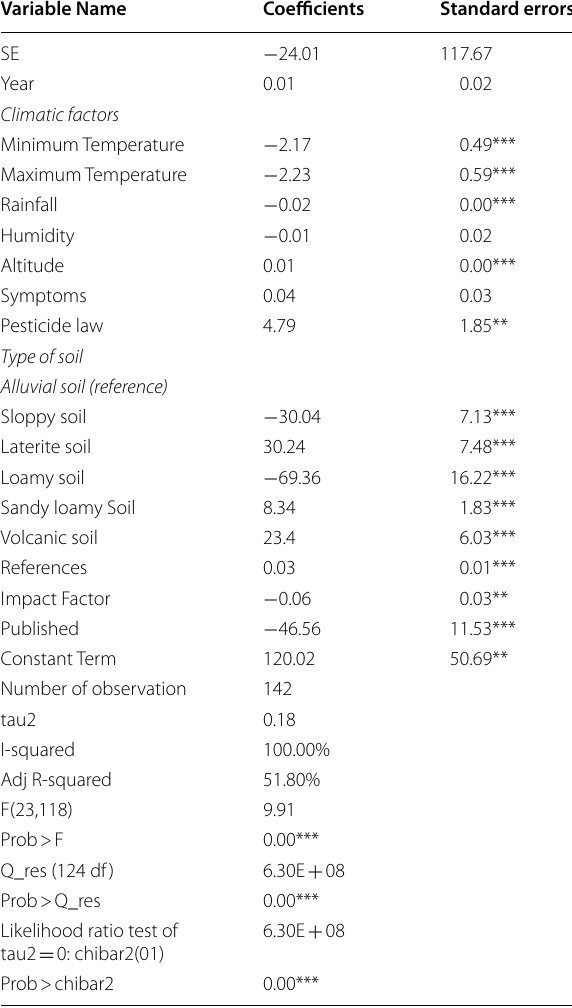
Table 3 Estimates of the meta